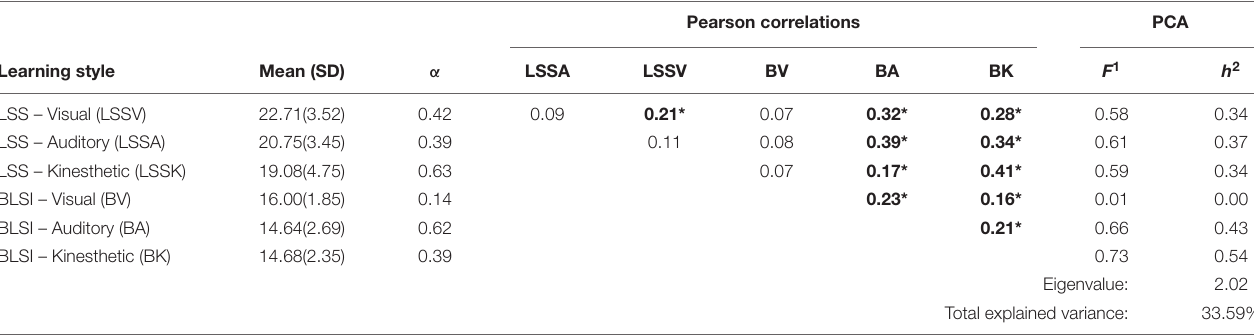
TABLE 3 | Descriptive statistics, internal consistency ( α ), Pearson correlations, and overview of principal component analysis of visual, auditory and kinesthetic learning style factors ( n = 248).